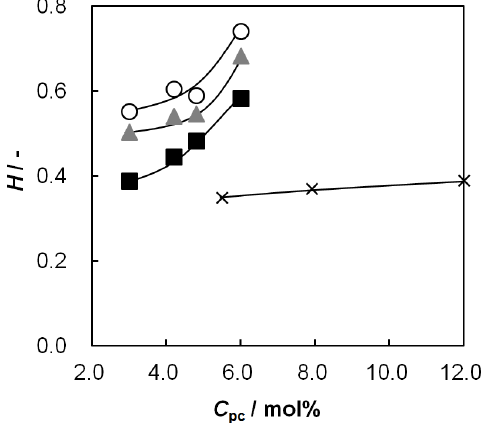
. Open and closed pc is 0.075 vol %. GA